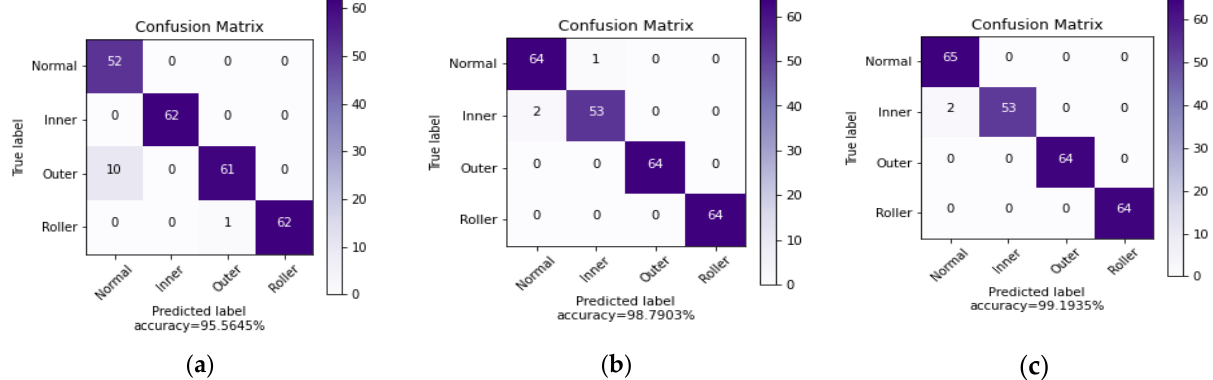
Figure 12. The confusion matrices for three CNN models using three different input images: ( a ) conventional wavelet spectrogram (CWS) image, ( b ) DSWI, and ( c ) EEMD + envelope analysis with CWT.